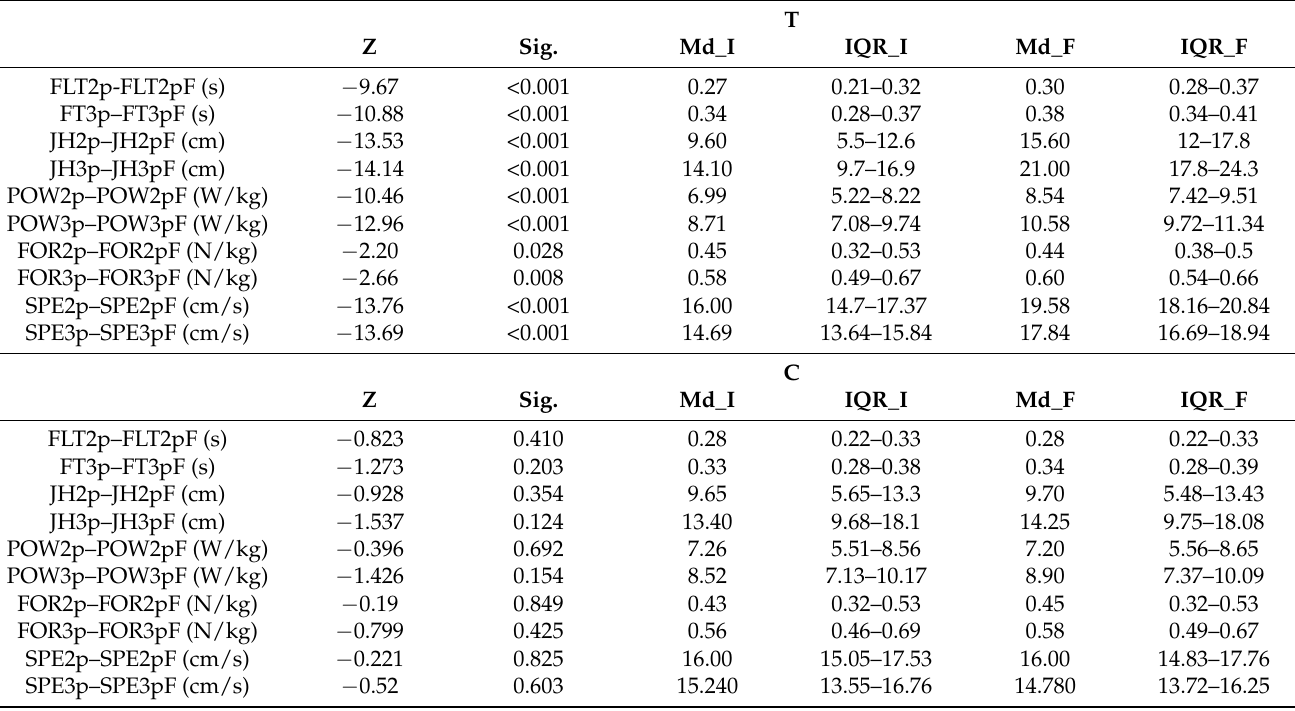
Table 2. Differences in experimental (T) and in control group (C) between the initial and final measurement calculated by the Wilcoxon test.